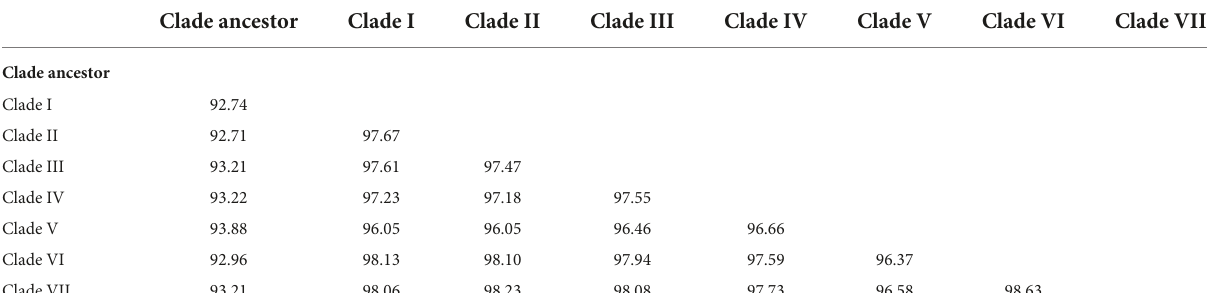
TABLE 3 Sequence identities (%) of different SVA clades.